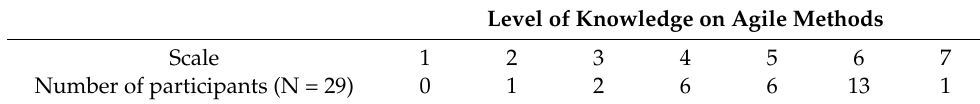
Table 3. Expertise of experts of the Delphi study in agile methods evaluated by